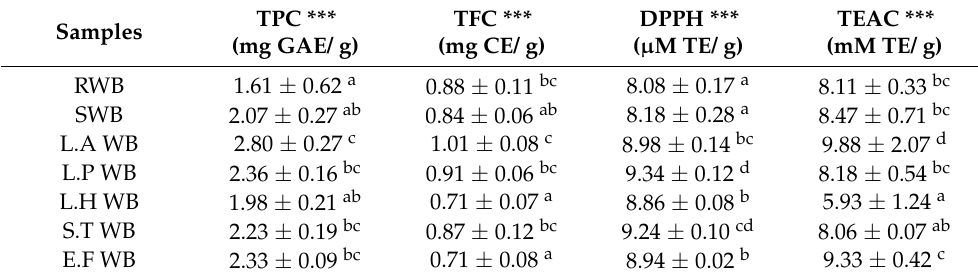
Table 3. Bioactive components and antioxidant activities of raw and fermented wheat bran.